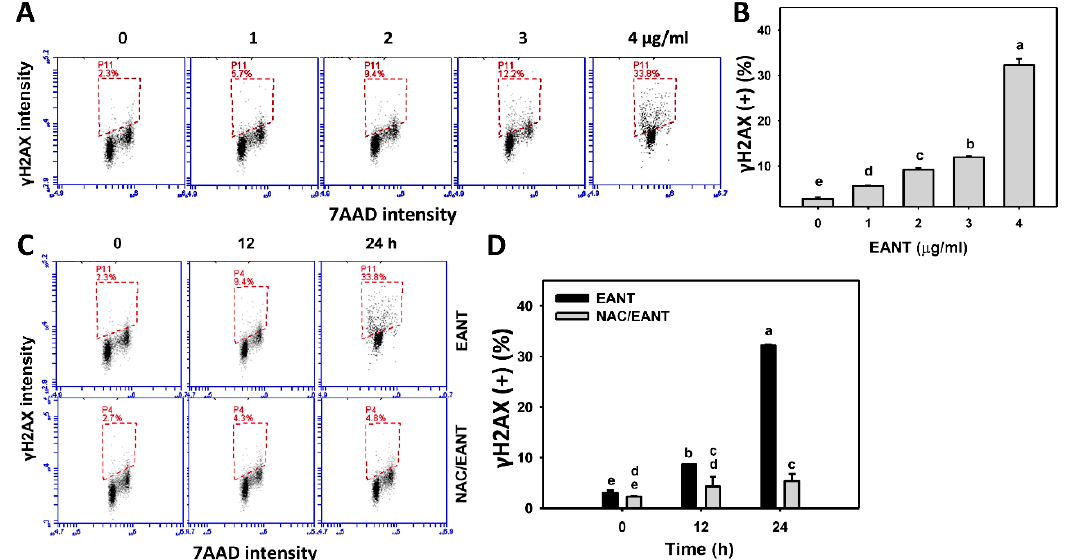
Figure 9. γ H2AX content of EANT-treated leukemia cells. ( A and B ) Histogram and statistical analysis for γ H2AX content. The dash-lined region of each panel is regarded as the population of γ H2AX (+) (%). HL-60 cells were treated with EANT (1 h, 0 to 4 μ g/mL). The control contained 0 μ g/mL EANT but 0.1% DMSO. ( C and D ) Histogram and statistical analysis for γ H2AX content of HL-60 cells following NAC/EANT treatment. NAC/EANT indicates that cells were either pretreated with NAC (5 mM, 1 h) or post-treated with EANT (0 and 4 μ g/mL for 0, 12, and 24 h). Data, mean ± SD ( n = 3). Data showing different alphabets at the top reveal a significant difference ( p < 0.05–0.0001 for multiple comparisons).